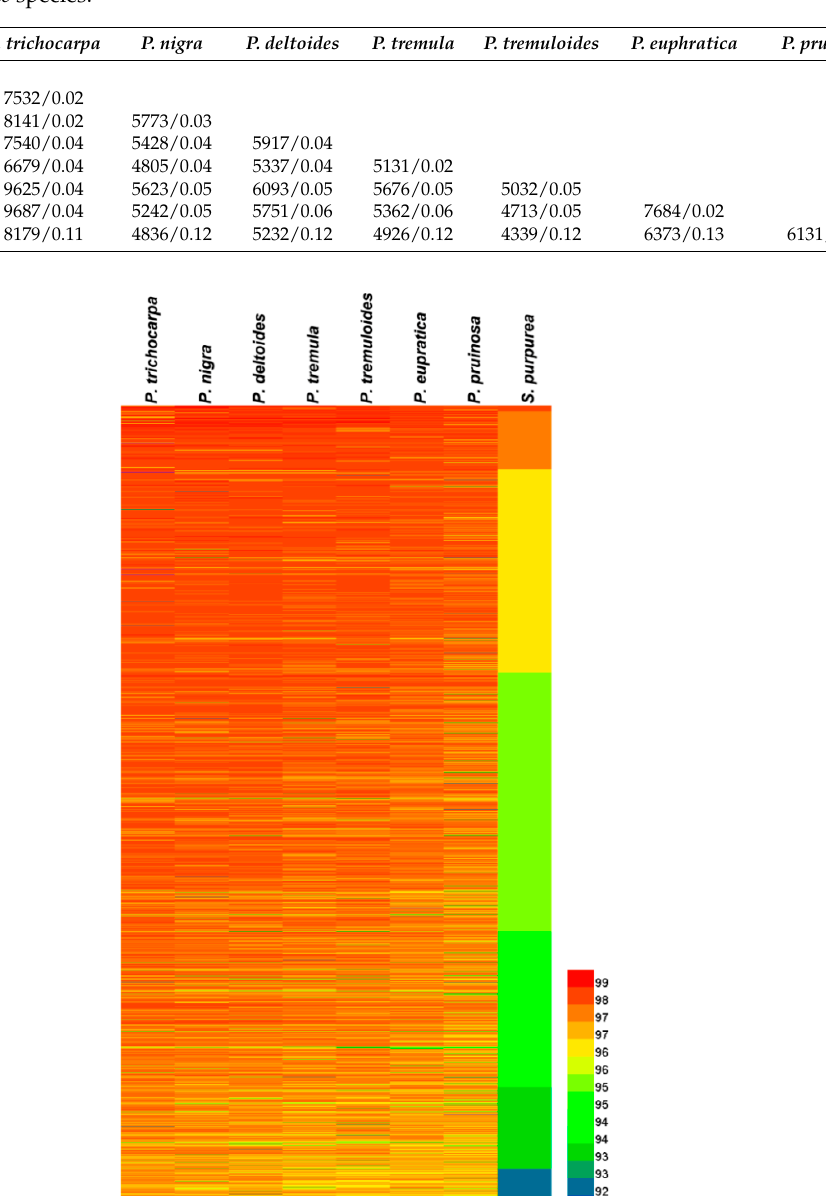
Figure 2. Divergence between orthologues of seven Populus and one Salix species. The heat map is drawn based on the combined sequences of 1835 putative orthologues in eight species. The orthologues were annotated to a different function with Gene Ontology (GO) (Table S1). Sequence similarity was indicated with different colors from red (highly similar) to blue (weakly similar).